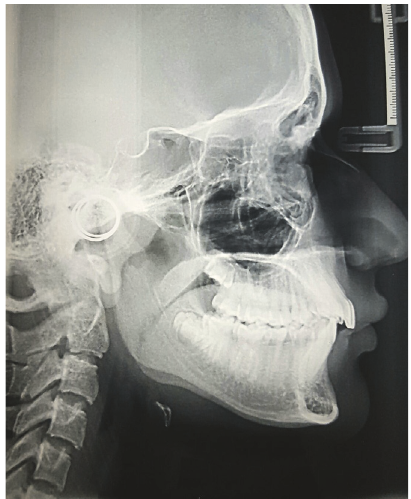
Table 1: Normal and pretreatment cephalometric values [12]. Variable Normal Pretreatment SNA 82 SNB 79 ANB 3 Upper incisor to SN (U1-SN) Lower incisor to mandibular plane (IMPA) Interincisal angle 130 SN-mandibular plane angle 32 Face height ratio 65%